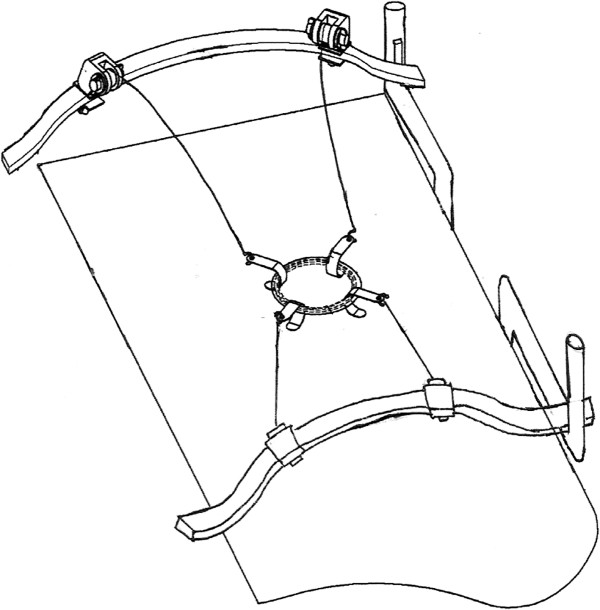
Instrument design.